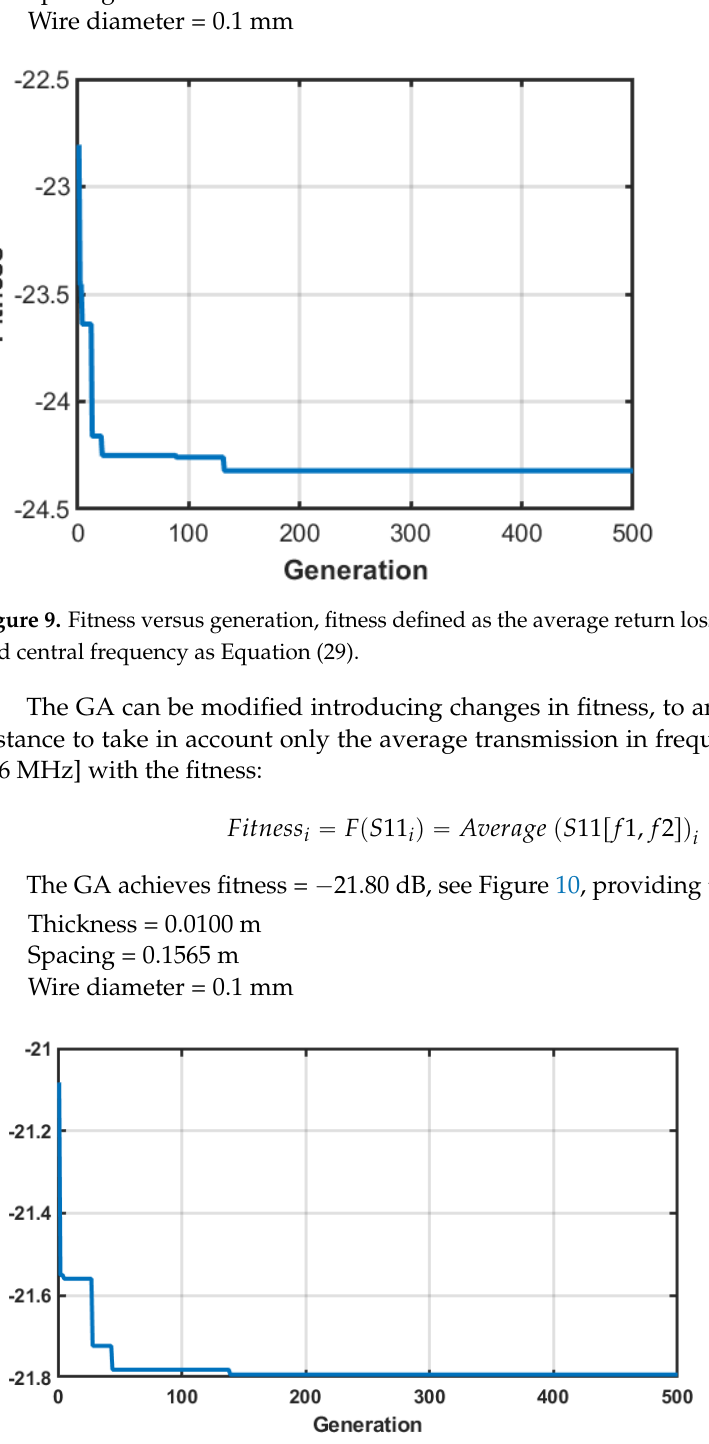
Figure 10. Fitness versus generation, fitness defined as the average reflection at the frequency band [470 MHz, 806 MHz], as Equation (30).